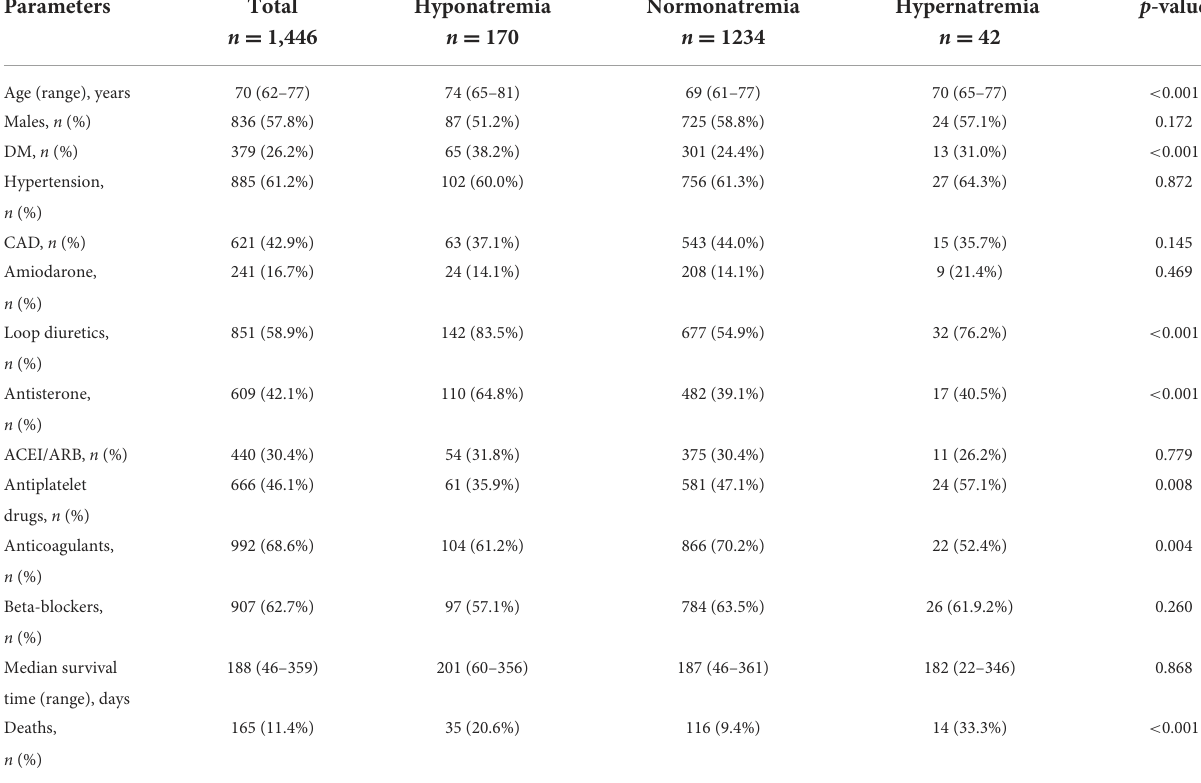
TABLE 1 Baseline characteristics of the study